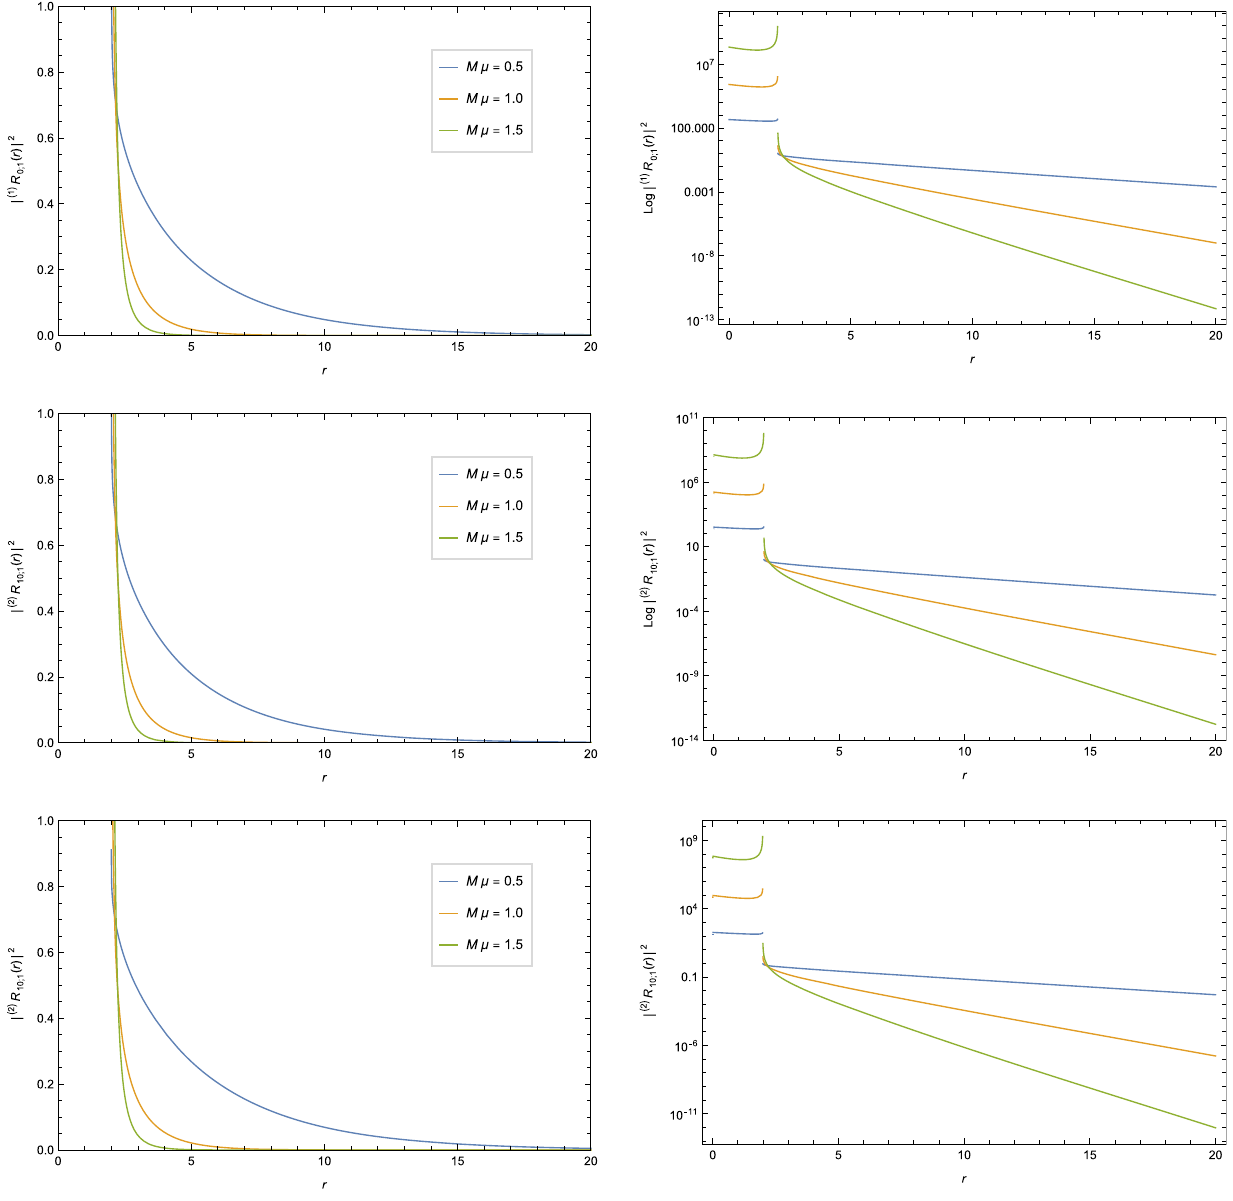
Fig. 5 The squared radial wave eigenfunctions for the fundamental mode N = 0. On the top, we show it in the Schwarzschild black hole. On the middle, we present it in the Kerr black hole for m = 1, and ( j ) Table 5 The eigenvalue λ , and the corresponding complex degree ν 0 M